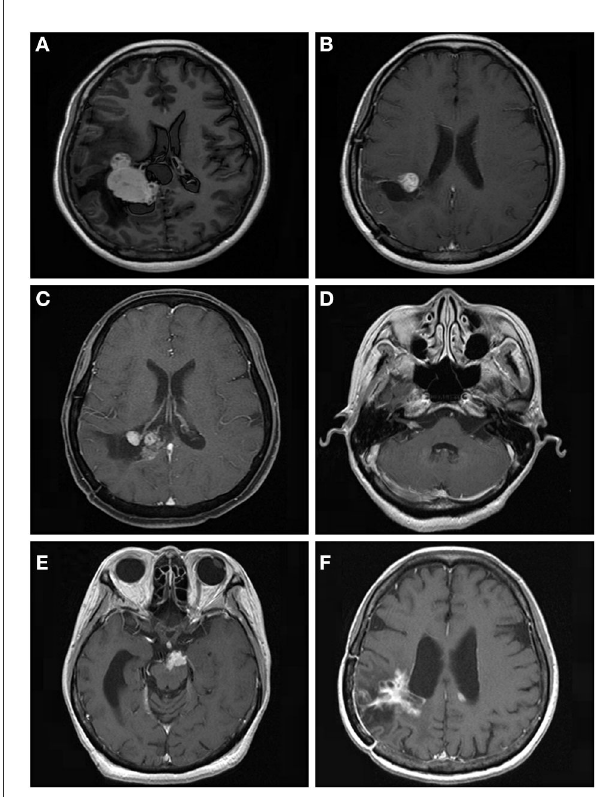
FIGURE3 A 53.9-year-old woman with intraventricular World Health Organization (WHO) grade I meningioma received Gamma Knife radiosurgery (GKRS) (margin dose, 13.5Gy; maximum dose, 30Gy) as adjuvant treatment for residual tumor after surgical resection. The patient developed local tumor progression and intracranial implantation metastasis at 59.9 and 111.7 months, respectively. (A) contrast-enhanced T1-weighted magnetic resonance imaging (MRI) scans showed an intraventricular tumor. (B) Adjuvant GKRS for residual meningioma after surgical resection. (C) The patient developed